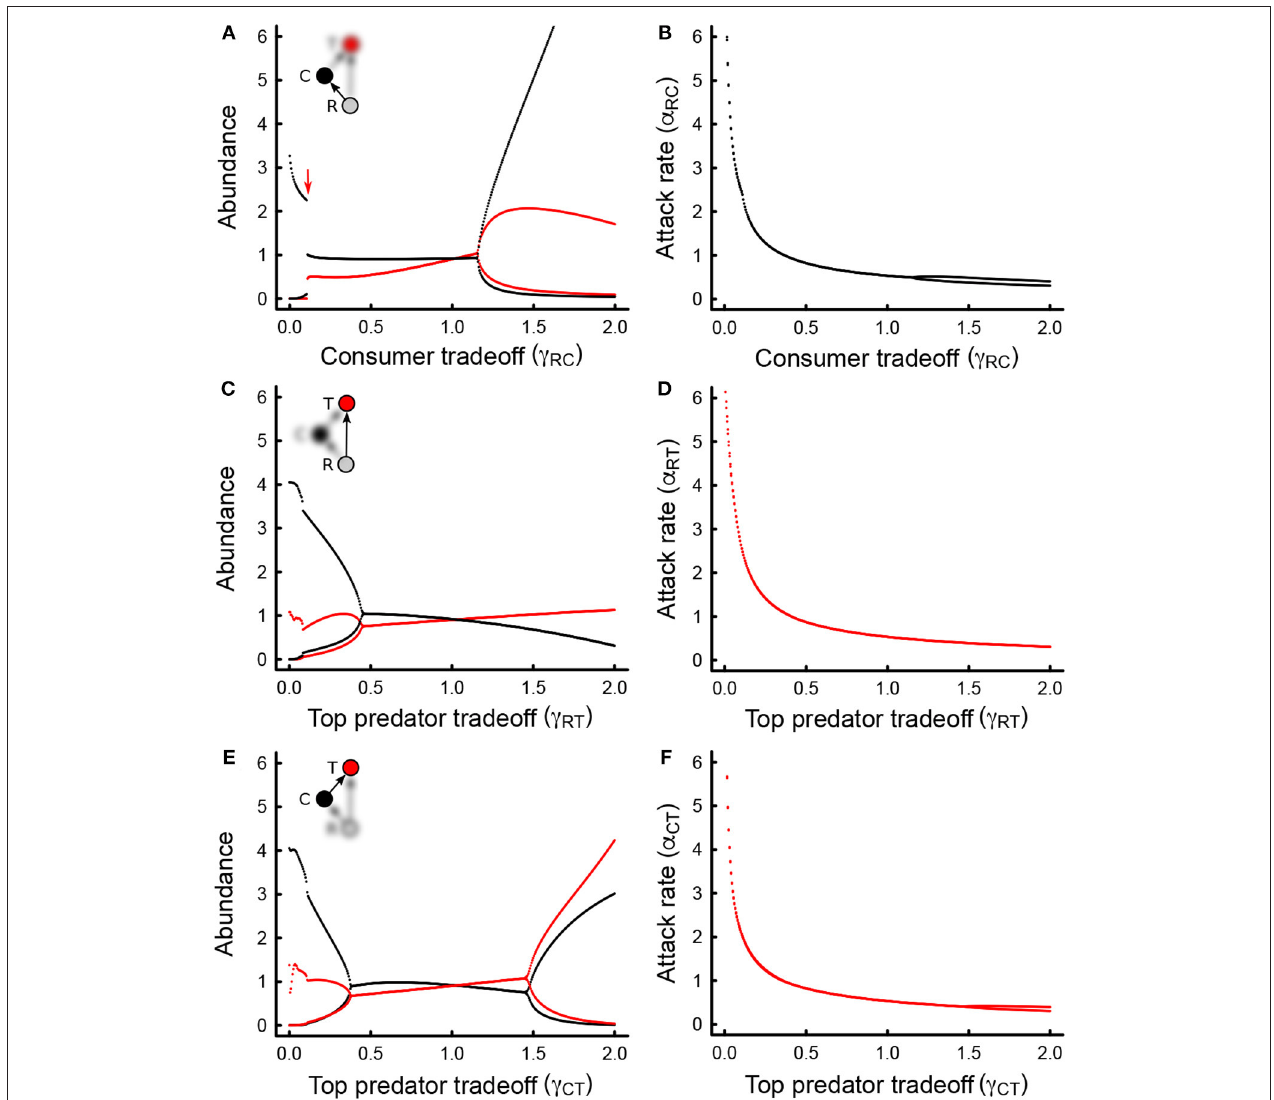
FIGURE 2 | (A) Bifurcation plots (abundance minima and maxima at equilibrium) for the top predator (red) and intermediate consumer (black), across increasing levels of the consumer tradeoff ( γ RC ). Only the attack rate between the consumer and the basal resource is allowed to evolve. Oscillatory behavior (instability) occurs whenever maxima and minima are not equal (there are two curves rather than one). The red arrow indicates the tradeoff value below which top predators cannot persist. (B) Same as in (A) but for the consumer attack rate instead of the abundance. (C) As in (A) but for the tradeoff associated with the attack rate between the top predator and the basal resource ( γ RT ). (D) As in (B) but for the interaction depicted in (C) . (E) As in (A,C) , but for the cost associated with the attack rate between the top predator and the intermediate consumer ( γ CT ). (F) As in (B,D) but for the interaction depicted in (E) . In all cases, only the focal attack rate is allowed to evolve, and all other parameter values are as in Table 1